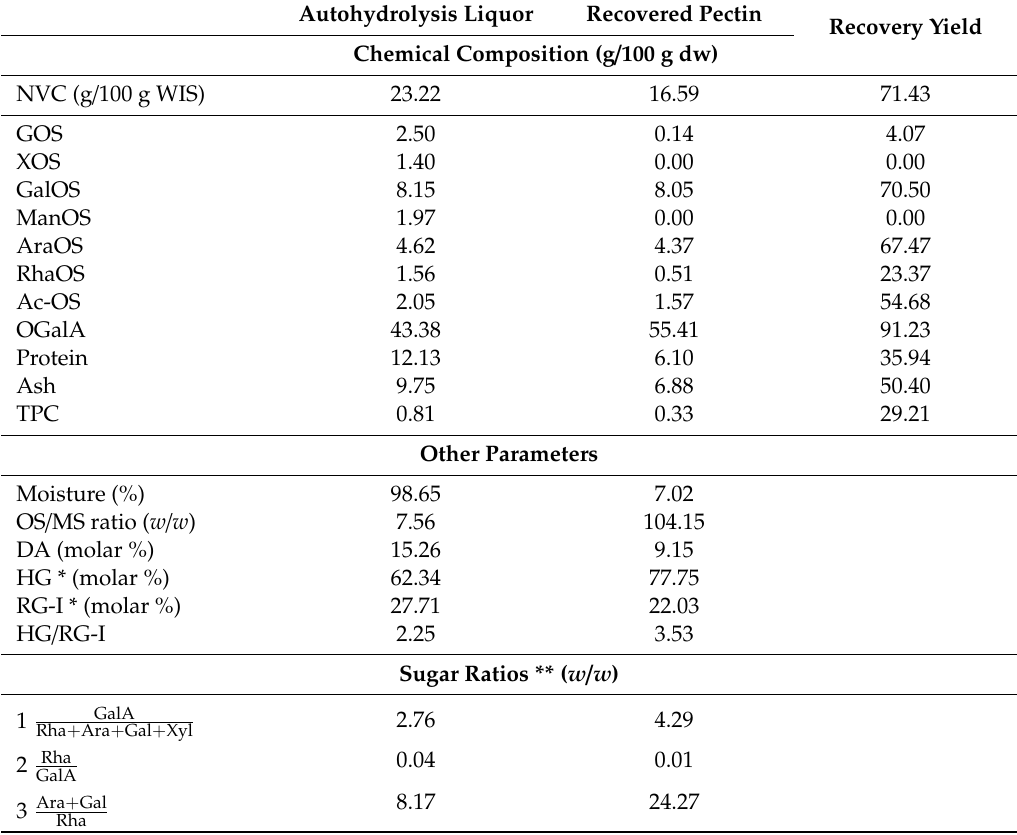
Table 2. Chemical characterization of the selected autohydrolysis liquor and the precipitated